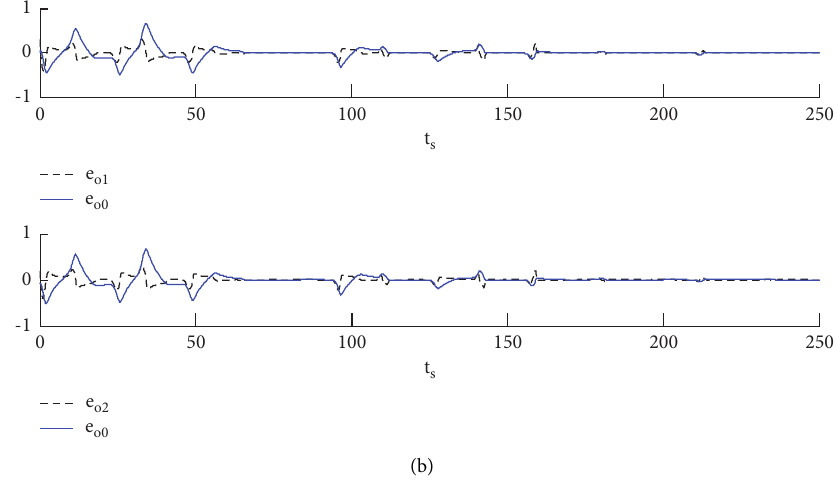
Figure 3: (a) Error between the master observer states and (b) that corresponding to the states of slave observers of Theorem